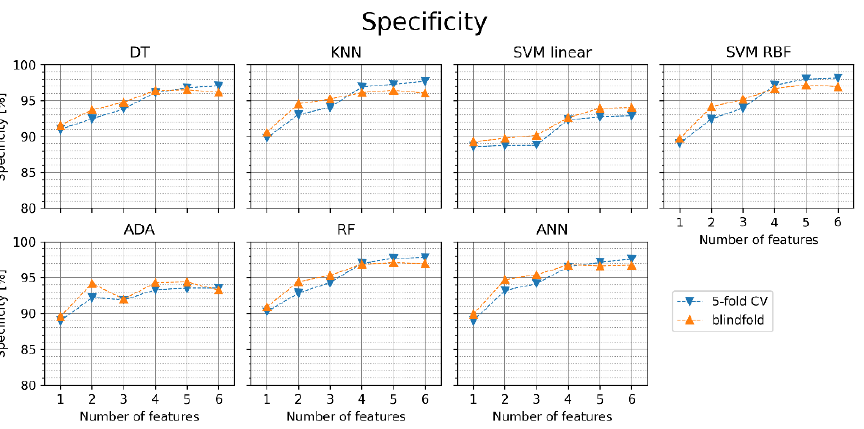
Figure 6. Sensitivity of atrial fibrillation detection for different classifiers with sets of one to six features (orange points—blindfold validation, blue points—5-fold cross-validation). DT—decision tree, KNN—K nearest neighbors, SVM linear—support vector machine with linear kernel, SVM RBF—support vector machine with radial basis function kernel, ADA—Ada Boost, RF—random forest, ANN—artificial neural network.